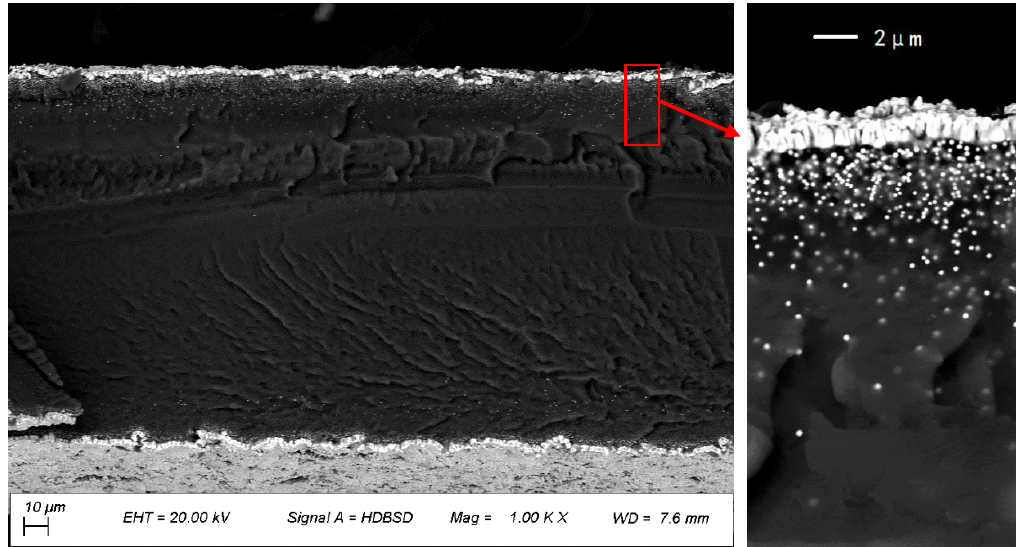
Figure 4. SEM cross-section of the samples (L2).